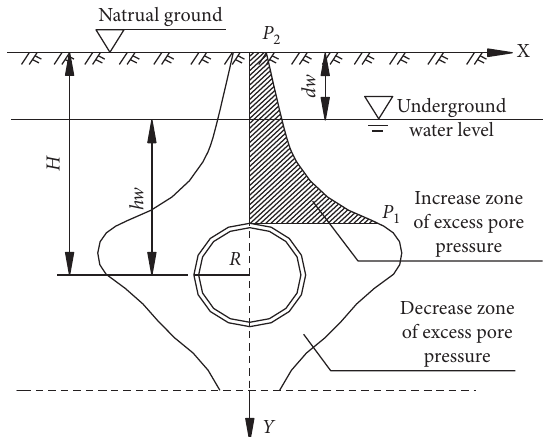
Figure 5: Distribution of excess pore water pressure.